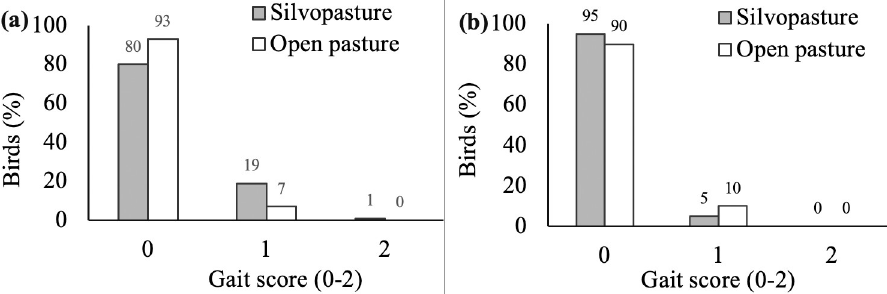
Fig 5. Percentage of birds with gait score 0–2 in the silvopasture and open pasture treatments. (a) On day 39 of age in Experiment 1 (n = 160). (b) On day 38 of age in Experiment 2 (n = 155).